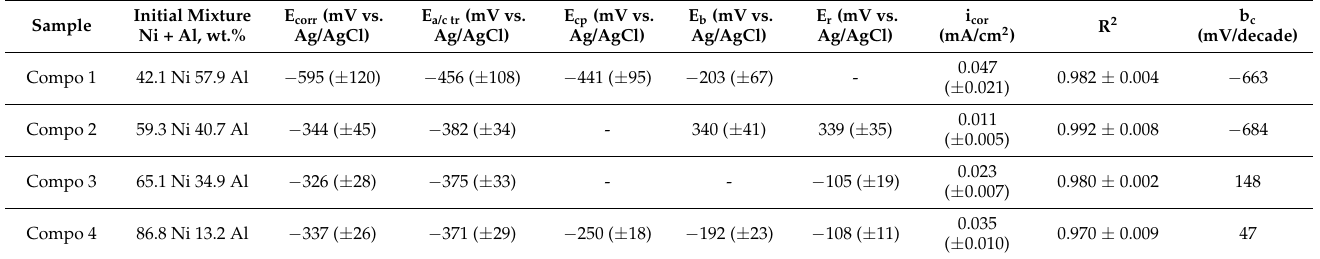
Table 3. Electrochemical values of the coatings immersed in 3.5% NaCl at 25 ◦ C: Effect of powder